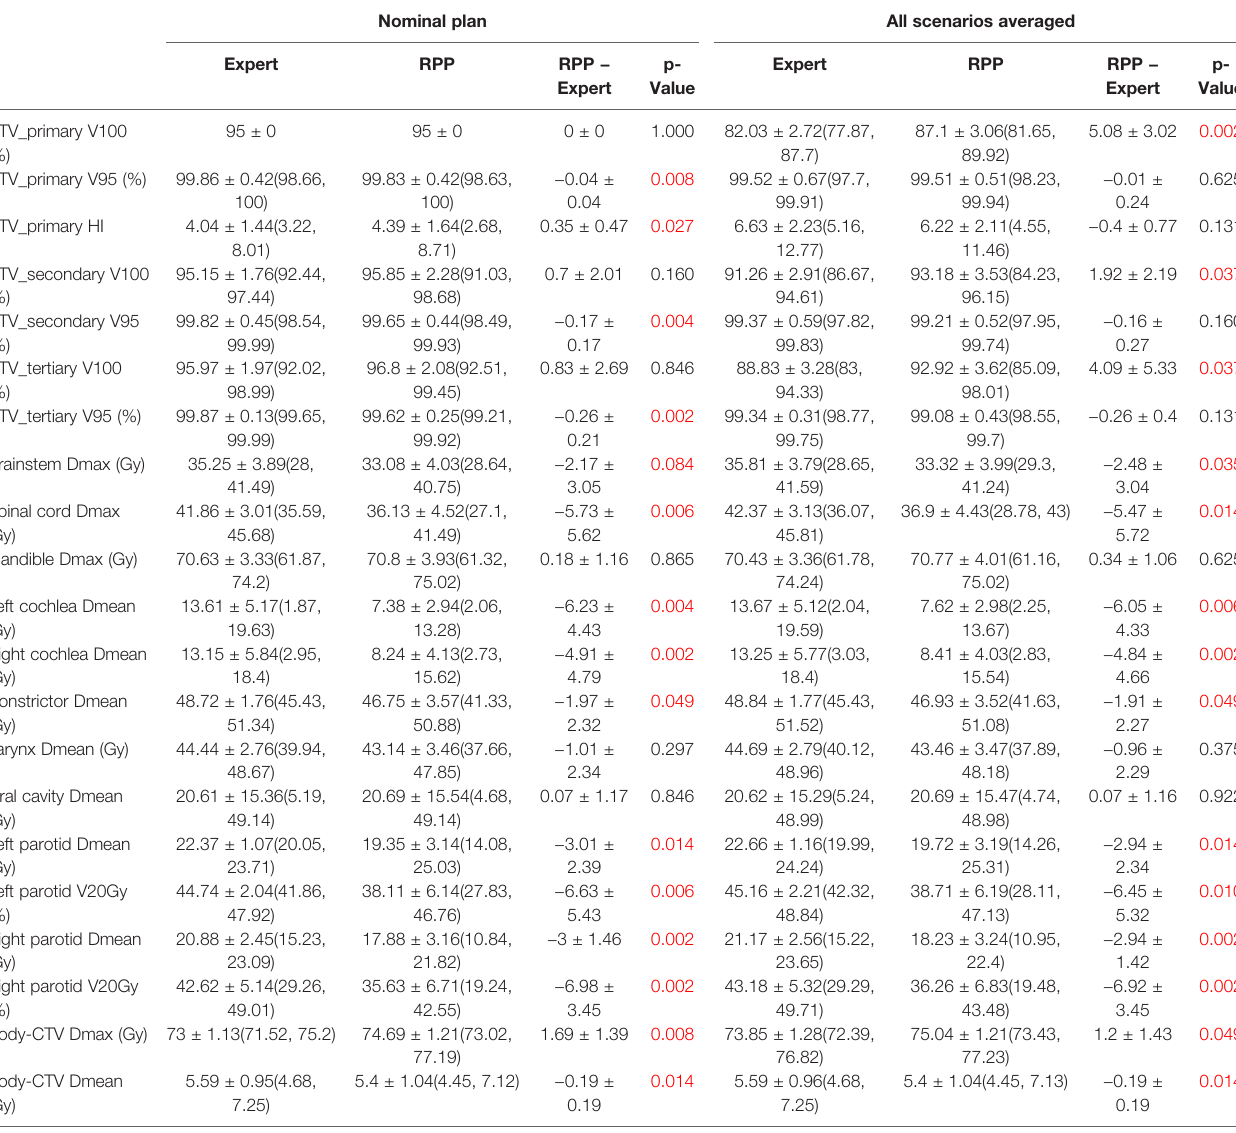
The data are presented as mean ± standard deviation, and the range is presented in brackets as (min max). RPP, RapidPlanPT. The red-colored values indicate statistically signi fi cant difference (p-Value<